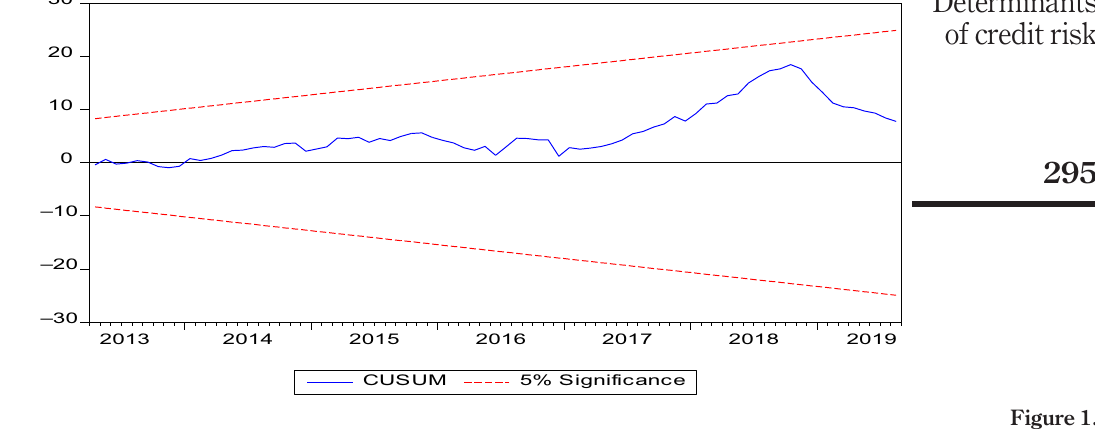
Figure 1. Result of CUSUM